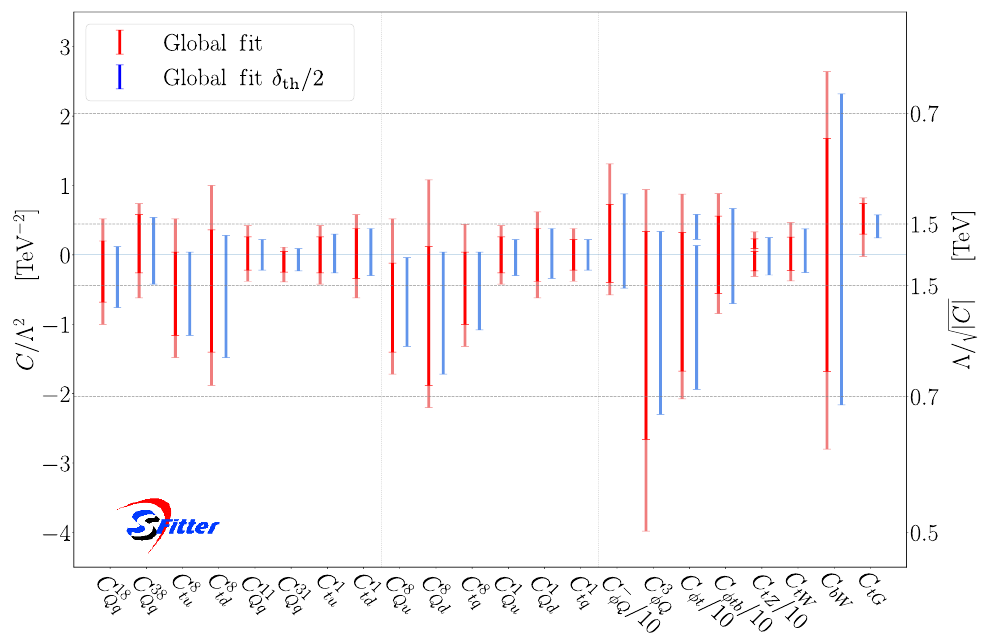
Figure 13 . 95% and 68% CL bounds on top operators from a global (cid:12)t to the full data set from tables 5 and 6. We show the results including all uncertainties (red) and with theoretical uncertainties reduced by a factor of two, (cid:14) th = 2